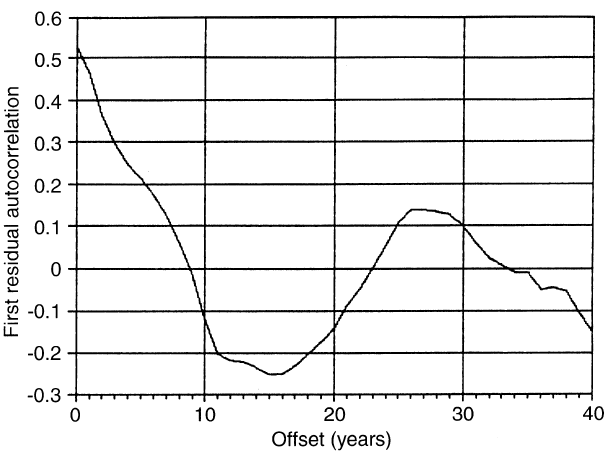
Fig. 2. Autocorrelation of